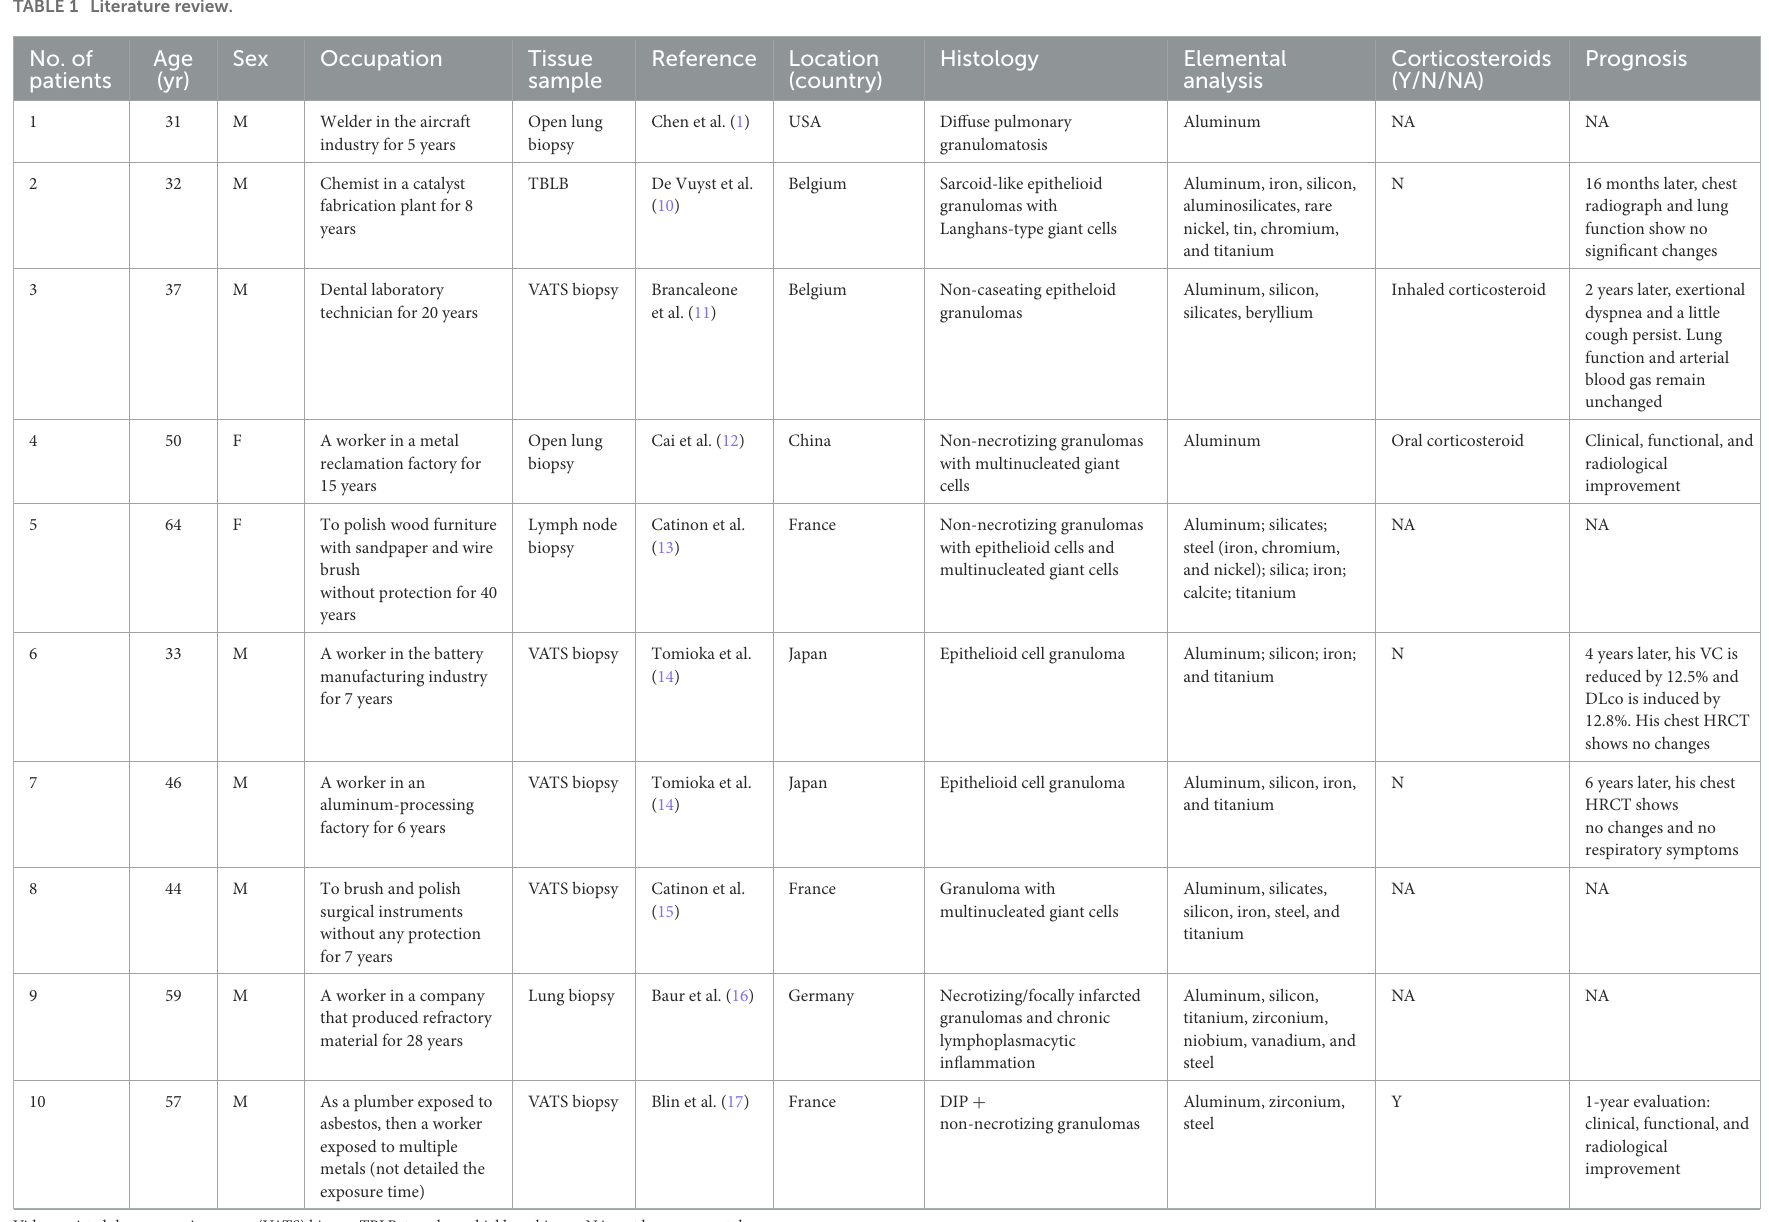
TABLE 1 Literature